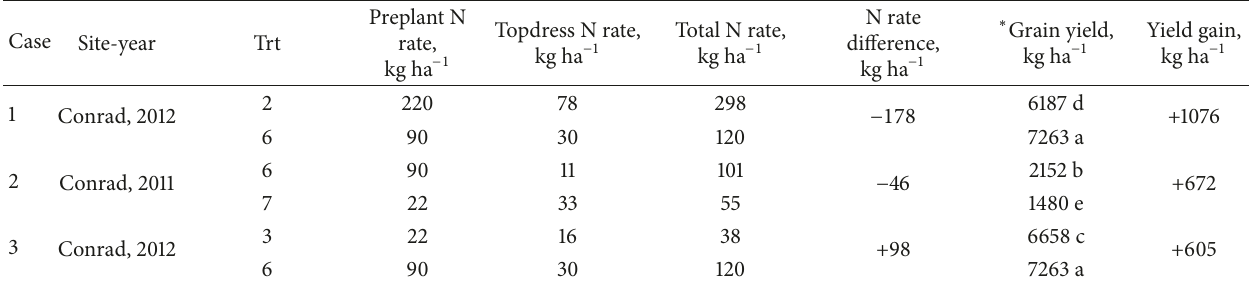
Table 6: Three cases illustrating topdress N rate recommendations prescribed by US-Canada-Mexico Algorithm and grain yield results obtained following the application of prescribed N